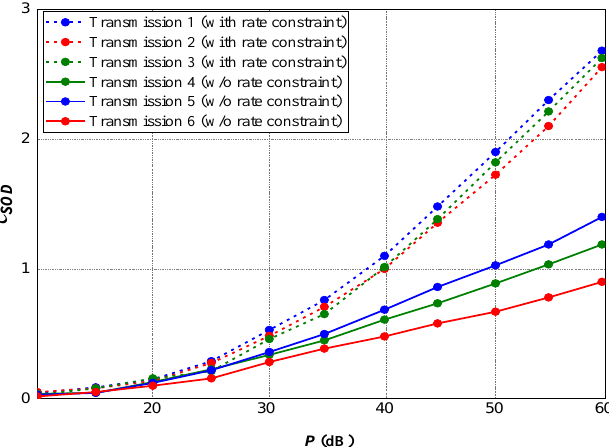
Figure 6. Source-to-Destination data rate for multiple destinations transmission.